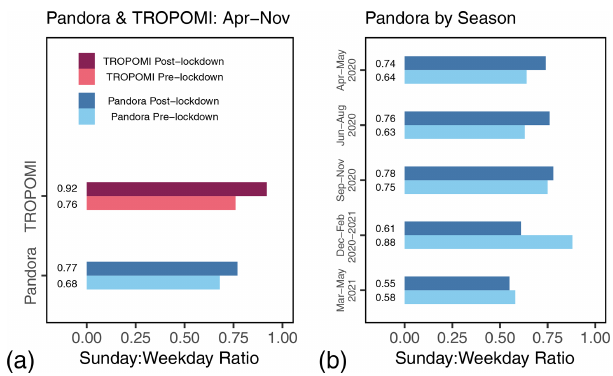
Figure 7. (a) Sunday-to-weekday TCNO 2 ratios averaged over April–November 2018–2019 (pre-lockdown) and 2020 (post- lockdown) from TROPOMI and Pandora (PSI#135); (b) sea- sonal change in Sunday-to-weekday column ratios pre- and post- lockdown from Pandora